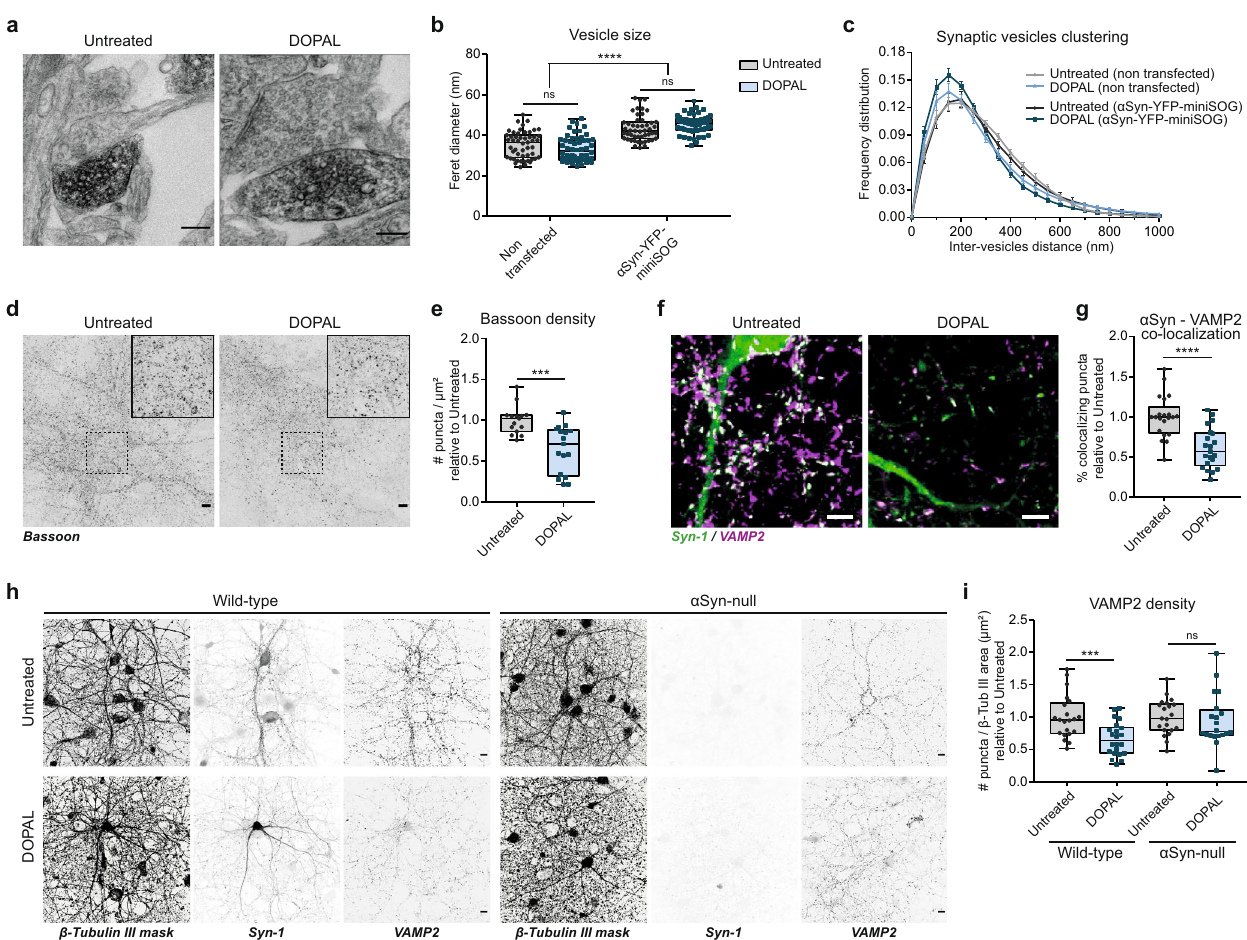
Fig. 3 DOPAL-induced α Synuclein buildup affects synaptic integrity. a In the CLEM experiment in Fig. 2f, representative electron micrographs of pre-synaptic terminals in photo-oxidized areas showing α Syn-miniSOG-positive terminals in close proximity to terminals from non-transfected neurons. Scale bar: 200 nm. b Quanti fi cation of synaptic vesicles mean size measured as Feret diameter (nm) and c frequency distribution of synaptic vesicles clustering expressed as inter-vesicles distance (nm). Data are pooled from two independent experiments, three photo-oxidized areas (non-transfected _ untreated: 51 synapses; non-transfected _ DOPAL-treated: 54 synapses; α Syn-miniSOG-positive _ untreated: 49 synapses; α Syn-miniSOG-positive _ DOPAL-treated: 59 synapses), and analyzed by Two-way ANOVA: b α Syn-overexpression **** p < 0.0001, treatment p > 0.05; c interaction **** p < 0.001, α Syn-overexpression p > 0.05. d Immunostaining of Bassoon in untreated and 100 μ M DOPAL-treated (for 24 h) primary rat cortical neurons. Scale bar: 10 µm. e Relative quanti fi cation of Bassoon-positive puncta per area unit (µm 2 ). f Immunostaining of α Syn (green) and VAMP2 (magenta) in untreated and 100 μ M DOPAL-treated (for 24 h) wild-type primary mouse cortical neurons. Scale bar: 5 µm. g Relative quanti fi cation of the percentage of α Syn-positive puncta colocalizing with VAMP2. h Immunostaining of β -Tubulin III (converted to binary mask), α Syn, and VAMP2 in wild-type and α Syn-null primary mouse cortical neurons with the same treatments. Scale bar: 10 µm. i The synaptic density is expressed as number of VAMP2-positive puncta normalized to the β -Tubulin III area (µm 2 ). Data from e three and g , i four independent cultures are normalized to each untreated sample, pooled together, and analyzed by Mann – Whitney test (*** p < 0.001, **** p < 0.0001). b , e , g , i Data are displayed as box and whiskers plot showing the minimum and maximum points (whiskers), the fi rst quartile, median and third quartile (box lines). c Data are shown as mean ± SEM each